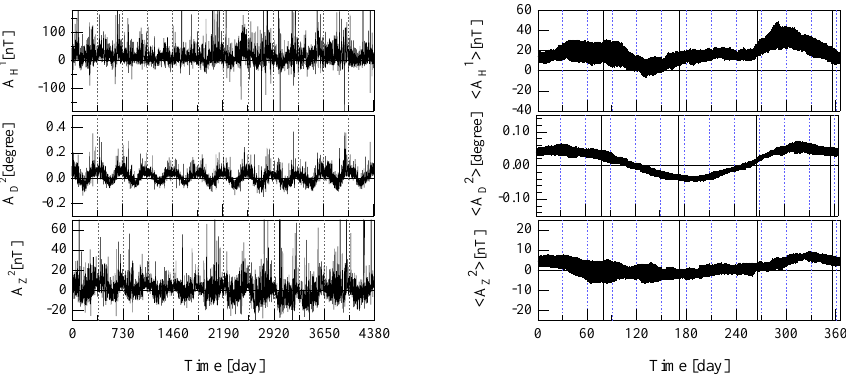
Fig. 7. The PCs associated with the EOFs reported in Fig. 6 for the 3 magnetic field elements (left panels) and the average annual behavior of PCs as evaluated applying the superposed epoch analysis (right panels). The vertical solid lines in right panels indicate the equinoxes and solstices.